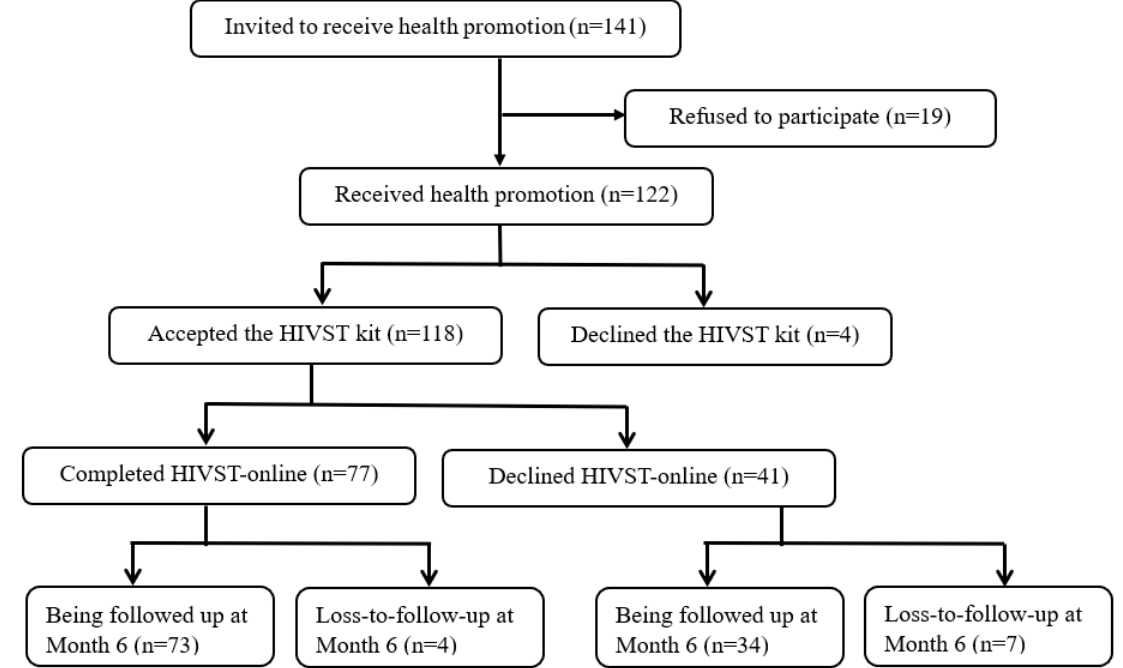
Figure 2. Flow diagram of the recruitment and uptake of HIVST ‐ online among ever ‐ users.